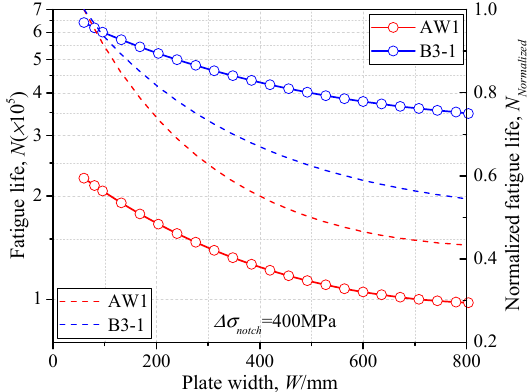
Figure 16. The N-W relationship. Figure 16. The N-W